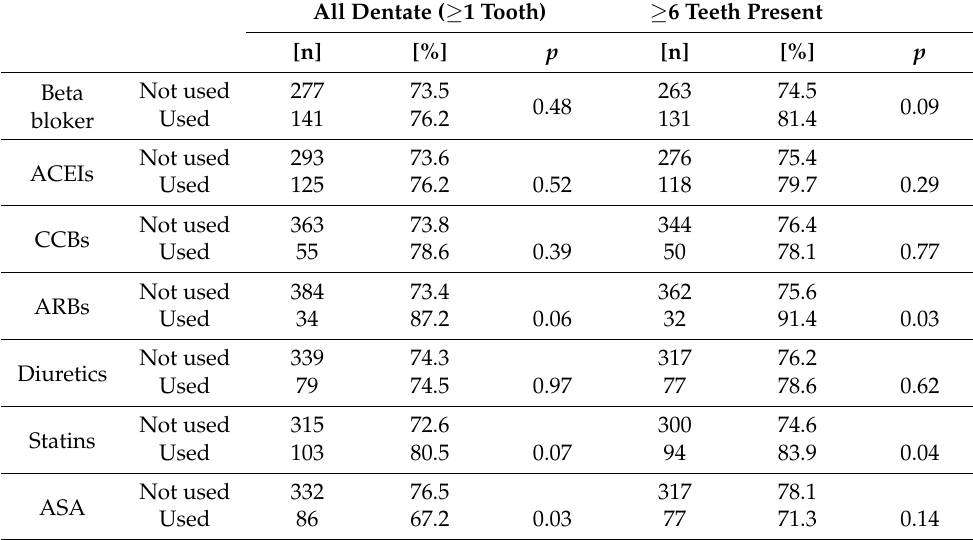
Table 4. Percentage of participants with periodontitis (% PD) using cardioprotective medications.